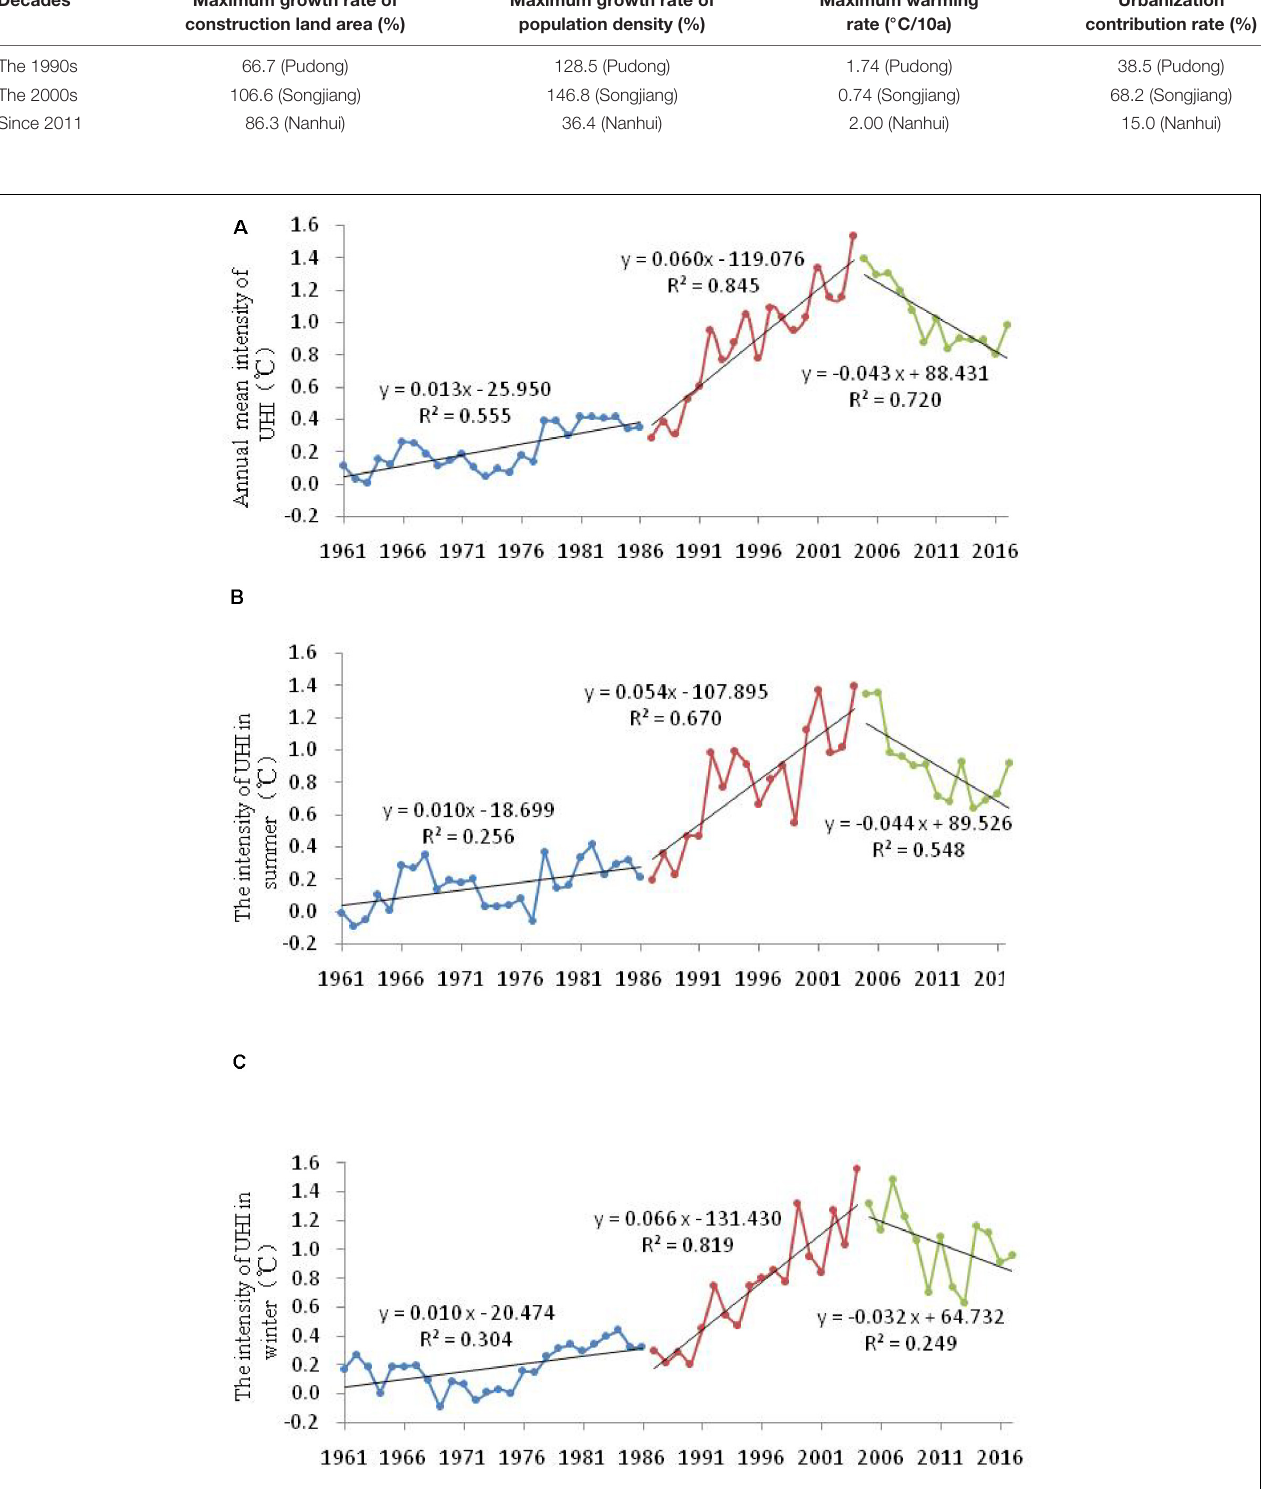
FIGURE 4 | The annual (A) , summer (B) , and winter (C) UHI intensities in Shanghai from 1961 to 2017.